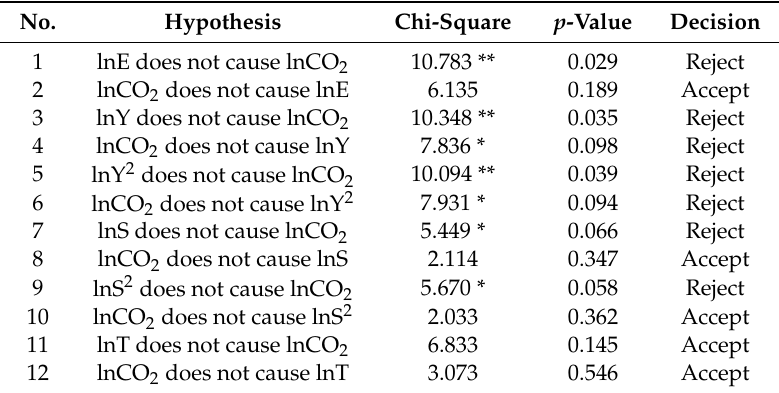
Table 9. The results of Toda and Yamamoto (TY) causality